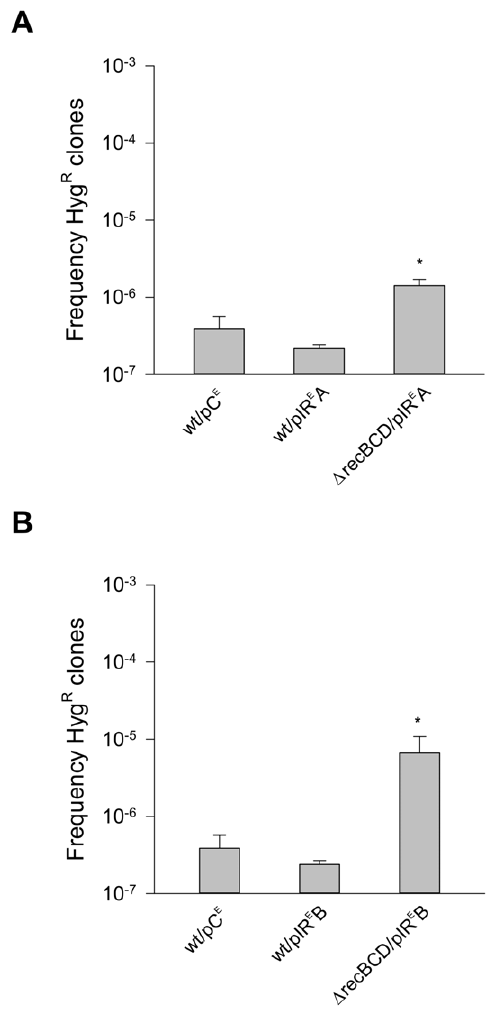
Figure 5. Precise deletions and SSA. RecBCD deficiency increases the frequency of precise deletions between IRs. Panels A and B , x-axis , M. smegmatis strains; y-axis , frequencies of Hyg R CFUs; asterisks , p , 0.05 (pair-wise Holm-Sidak test for D recBCD M. smegmatis against wild-type). Panel A , wt/pC E , wild-type/pMV206KmHyg::Gm (control); wt/pIR E A , wild- type/pMV206KmHyg::Oligo IR Gm A lac Z; D recBCD/pIR E A , D recBCD/ pMV206KmHyg::Oligo IR Gm A lac Z. Panel B , wt/pC E , as in Panel A; wt/ pIR E B , wild-type/pMV206KmHyg::Oligo IR Gm B ; D recBCD/pIR E B , D recBCD/ pMV206KmHyg::Oligo IR Gm B